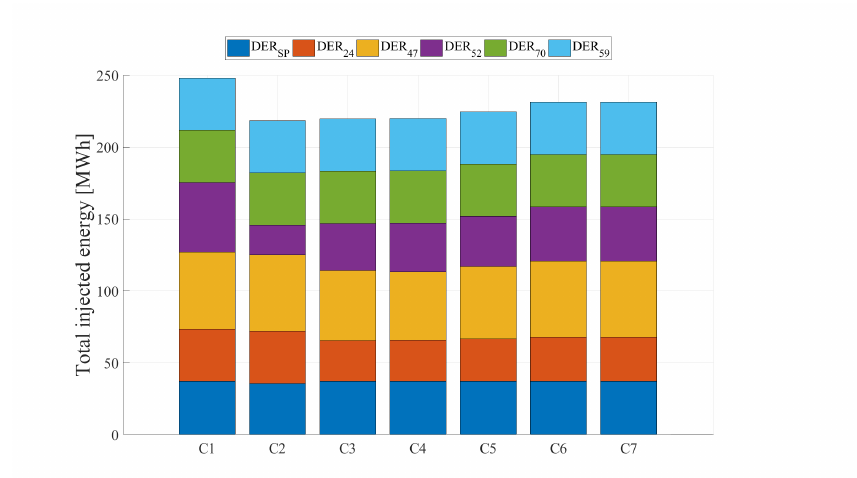
Figure 11. Total annual injected power by DERs when different control strategies are applied.